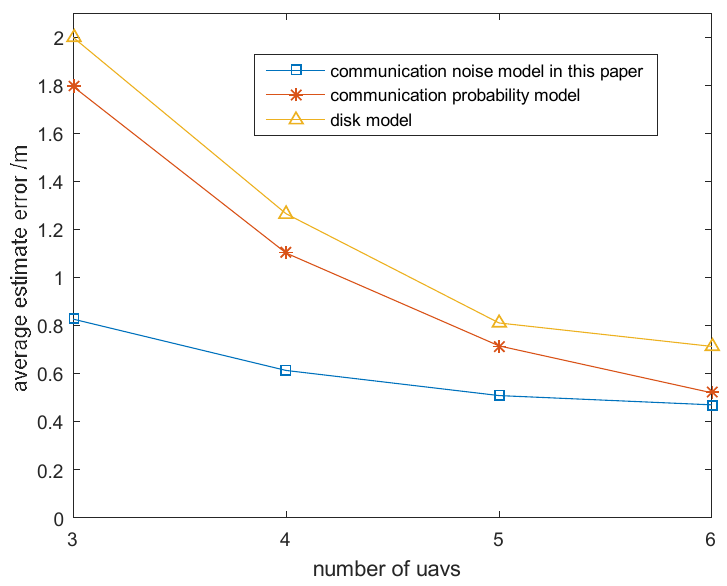
Figure 10. The impact of number of UAVs on average estimate error.